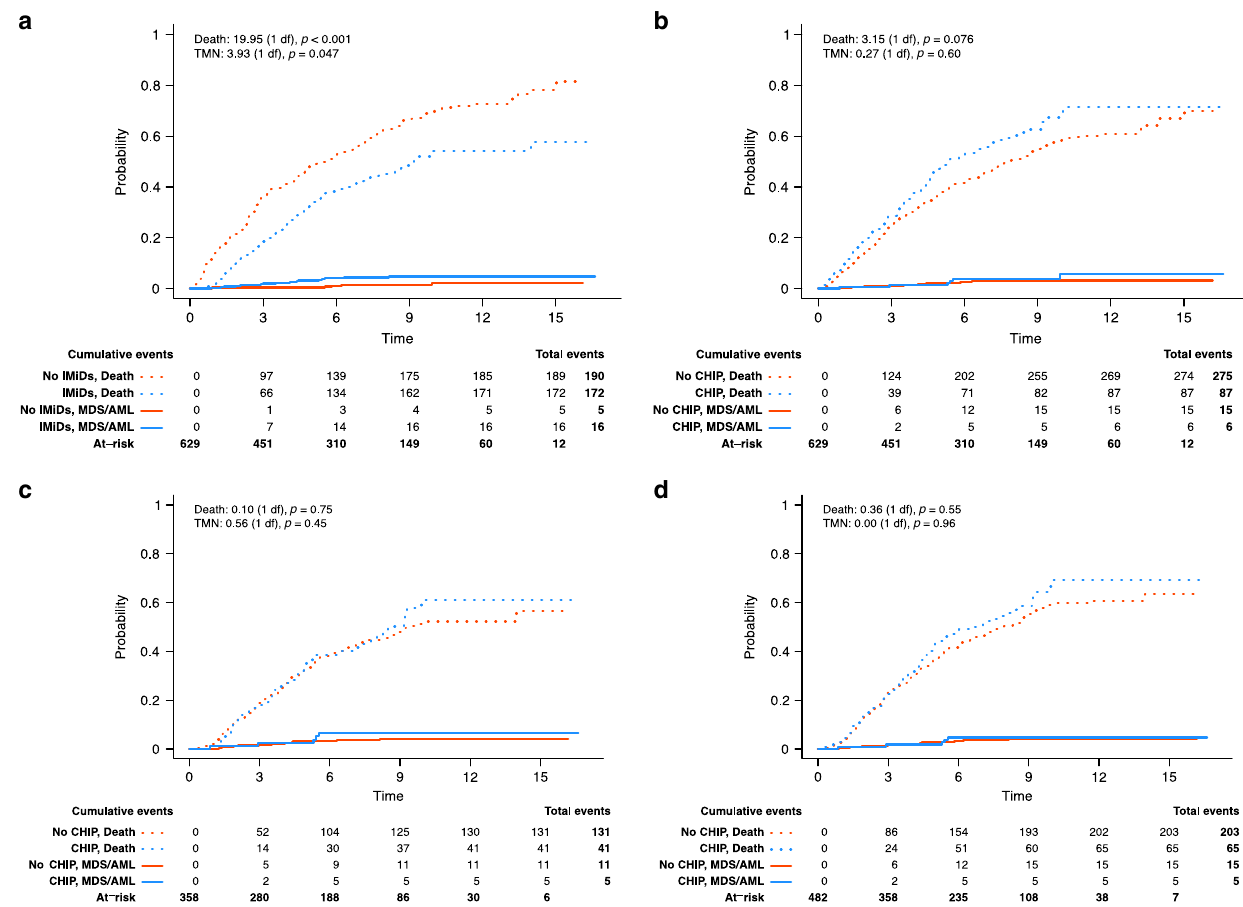
Fig. 2 Outcome of immunomodulator maintenance and CHIP in the context of therapy related myeloid neoplasms (TMN). a Cumulative incidence of MDS/AML in patients with IMiD maintenance versus patients without maintenance, with death as an absorbing competing risk. Cumulative incidence of developing MDS/AML among patients with CHIP vs. no CHIP, with death as an absorbing competing risk, b among all patients, c patients receiving fi rst- line IMiD maintenance and d patients receiving IMiDs at any point post ASCT. Groups were tested for equality using a two-sided Gray ’ s test to compare subdistributions for each competing risk.